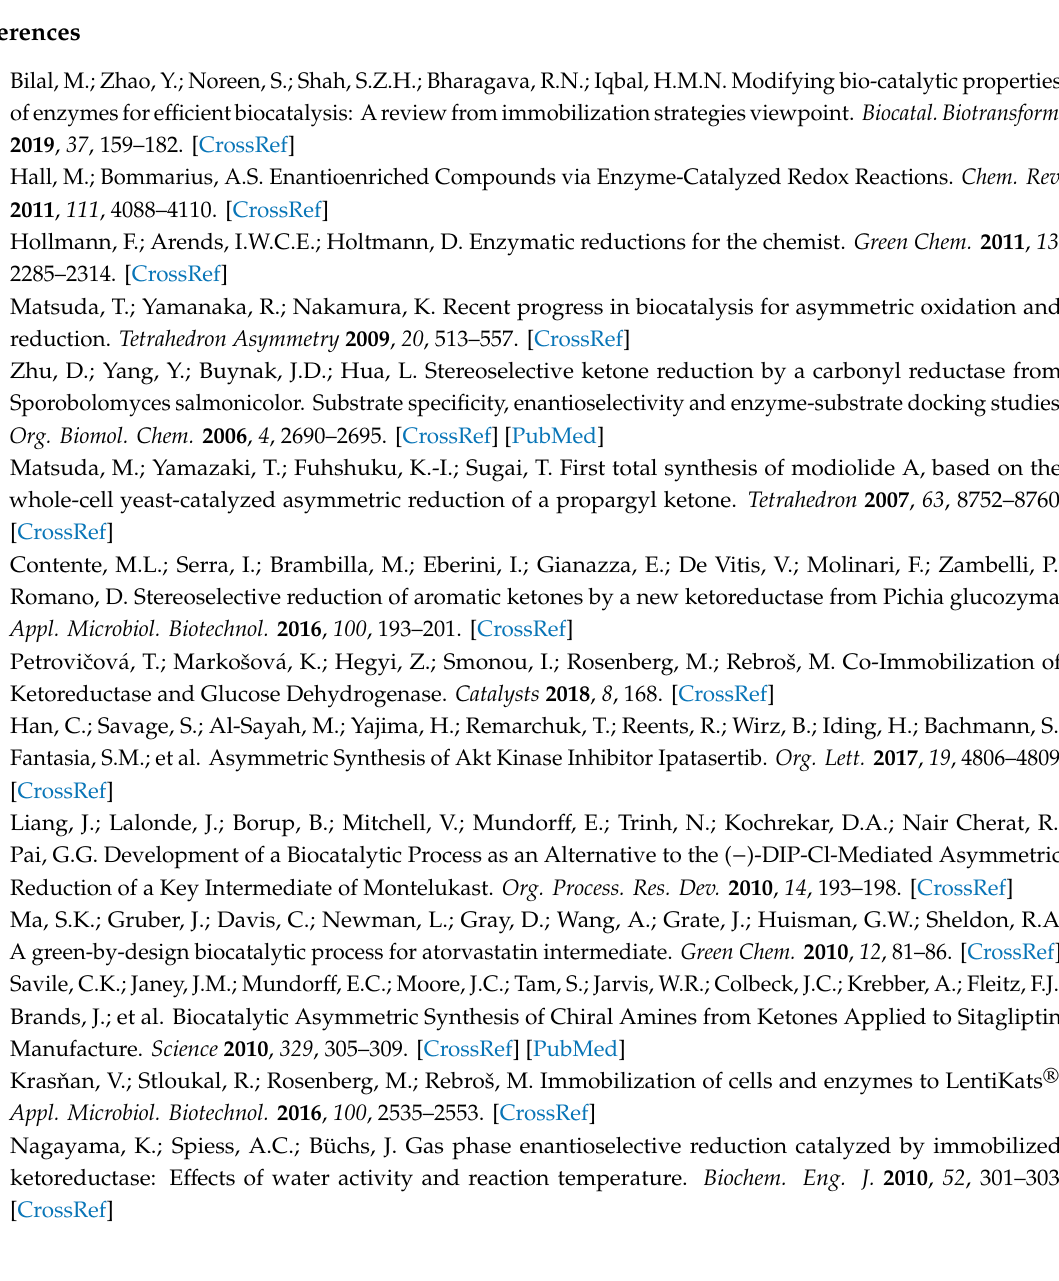
Supplementary Materials: Figure S1: Presence of ketoreductase in E.coli cells, Figure S2: Di ff erent loading strategies for a ffi nity immobilization, Figure S3: Increase in product concentration for various loading strategies, Figure S4: Comparison between use of crude cell extract and isolated enzymes, Figure S5: Activity of immobilized biocatalyst at di ff erent pH and temperature, Figure S6: Decrease in the initial enzymatic activity with increasing initial substrate concentration, Figure S7: Repeated biotransformations (1st–20th reaction)-130mM of substrate, Figure S8: Repeated biotransformations (1st–13th reaction)-190 mM of substrate, Figure S9: Decrease in activity of stored